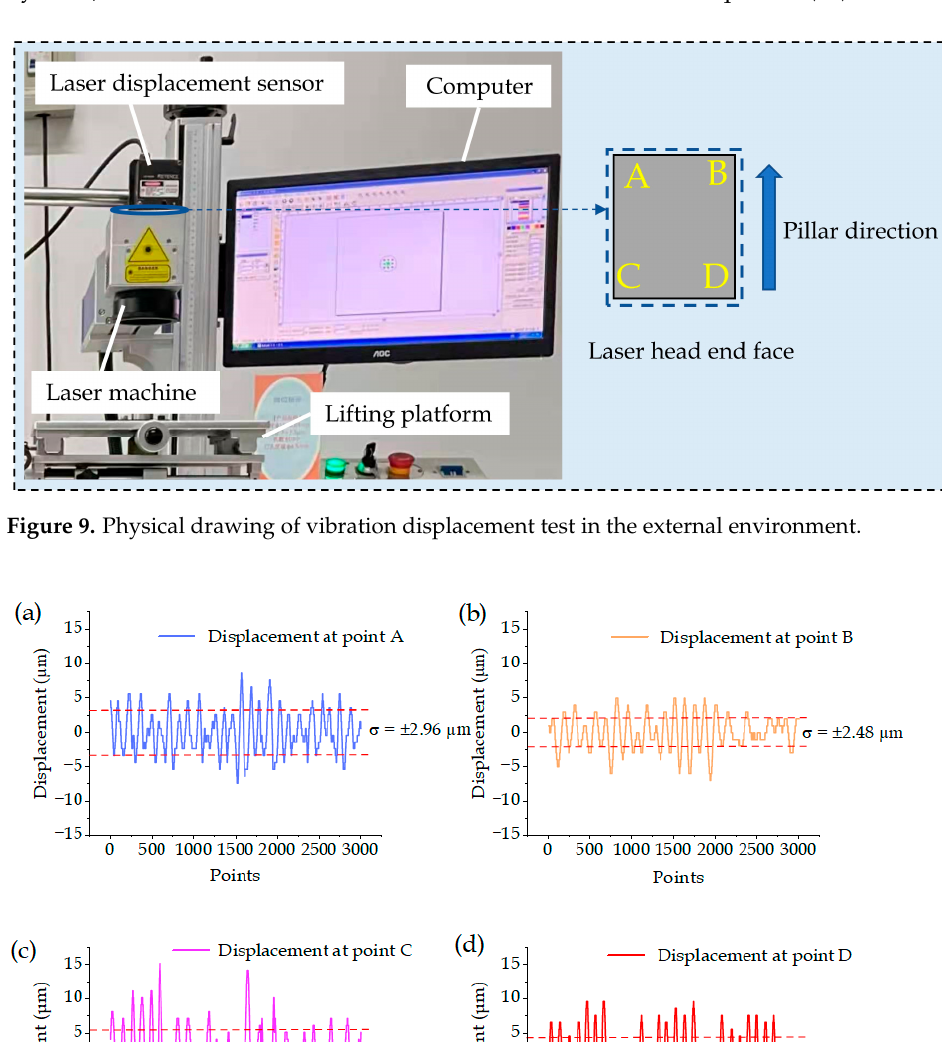
Figure 11. Amplitude–frequency diagram of vibrations on the laser machine: ( a ) amplitude– frequency diagram of point A; ( b ) amplitude–frequency diagram of point B; ( c ) amplitude– frequency diagram of point C; ( d ) amplitude–frequency diagram of point D. 5.2. Interference Error Experiment on the Electrical System and Optical Control System Inside the Laser Machine